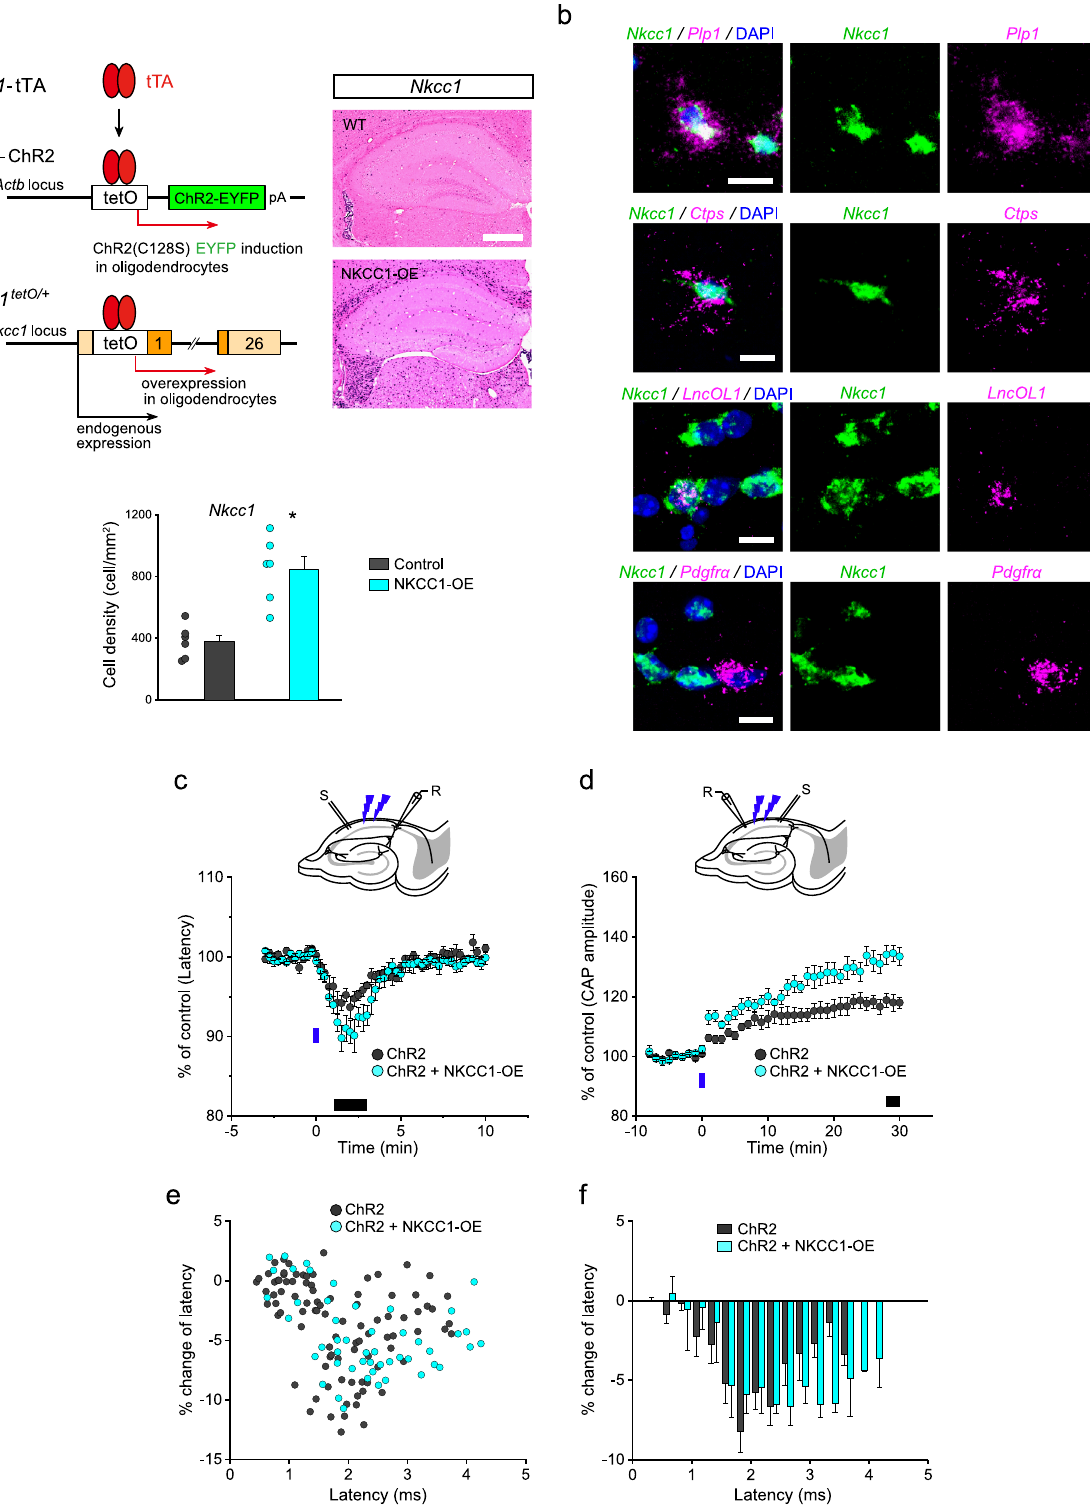
(Supplementary Fig. 8b), indicating that Nkcc1 overexpression did not affect basal cellular properties. The function of Nkcc1 overexpressed on OLs (>PND 35) was con fi rmed by the larger magnitude of GABA-induced